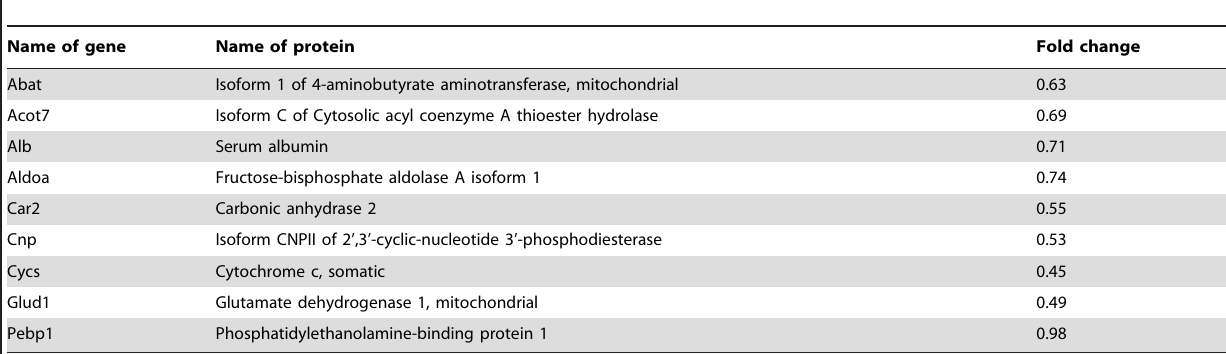
Table 4. Down-regulated proteins due to spaceflight (vs. ground